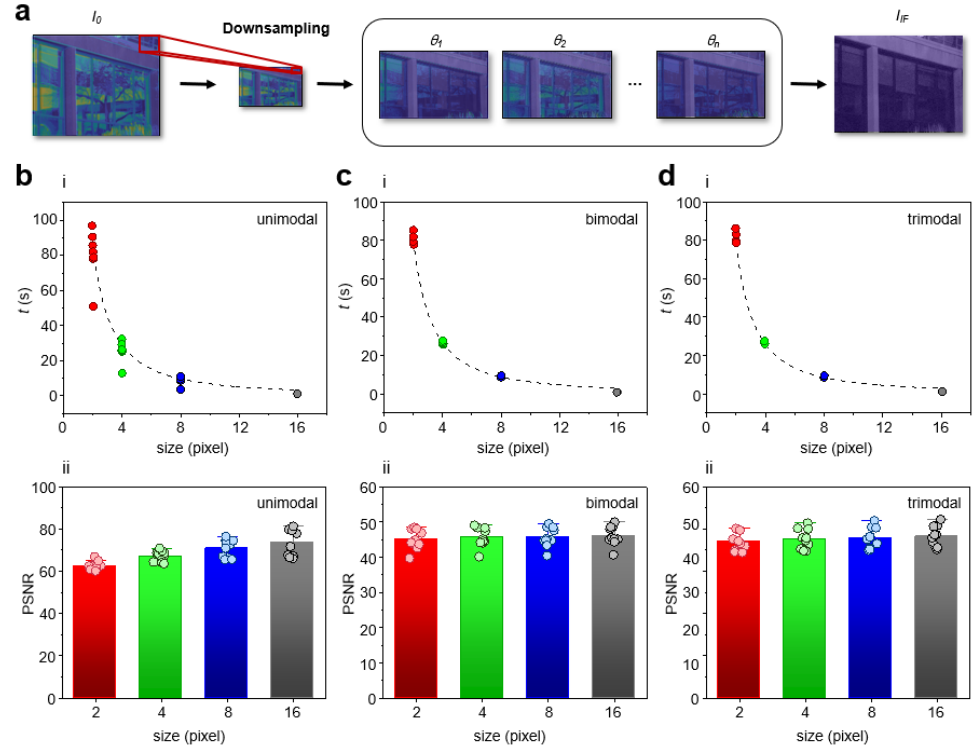
Figure 4. IF algorithm increased time performance without compromising image quality. ( a ) Conceptual schematic of the downsampling process in the IF algorithm. During the intelligent polarization selection process, the input dimensions of images were reduced. IF determined optimal polarizations using iterative feedback. The fusion image was reconstructed by selecting the pixel value at the image index where the pixel-weight was the minimum on a per-pixel basis. I IF was free of lighting obstructions. ( b ) Single optimal polarization present (unimodal): ( i ) Graph of time versus downsampling factor (red, green, blue, grey colors). ( ii ) Graph of PSNR versus downsampling factor (red, green, blue, grey colors). ( c ) Multiple optimal polarizations present (bimodal): ( i ) Graph of time versus downsampling factor (red, green, blue, grey colors). ( ii ) Graph of PSNR versus downsampling factor (red, green, blue, grey colors). ( d ) Multiple optimal polarizations present (trimodal): ( i ) Graph of time versus downsampling factor (red, green, blue, grey colors). ( ii ) Graph of PSNR versus downsampling factor (red, green, blue, grey colors).